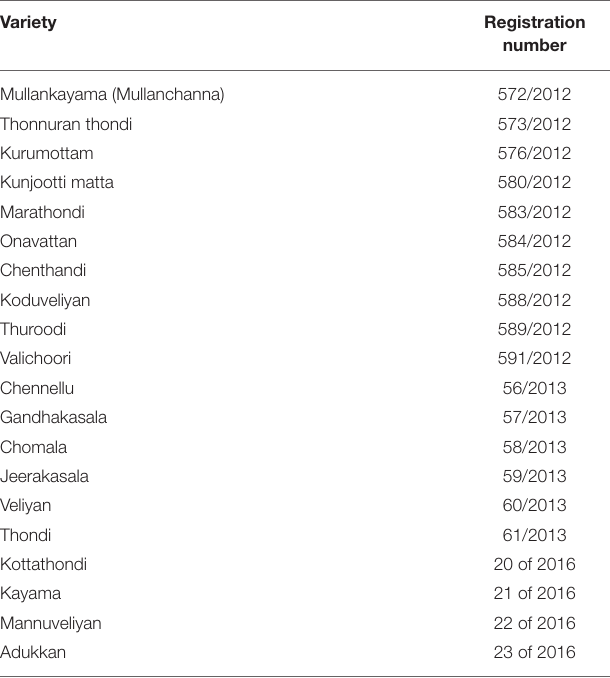
TABLE 1 | Registered farmers’ rice varieties cultivated in Kerala.